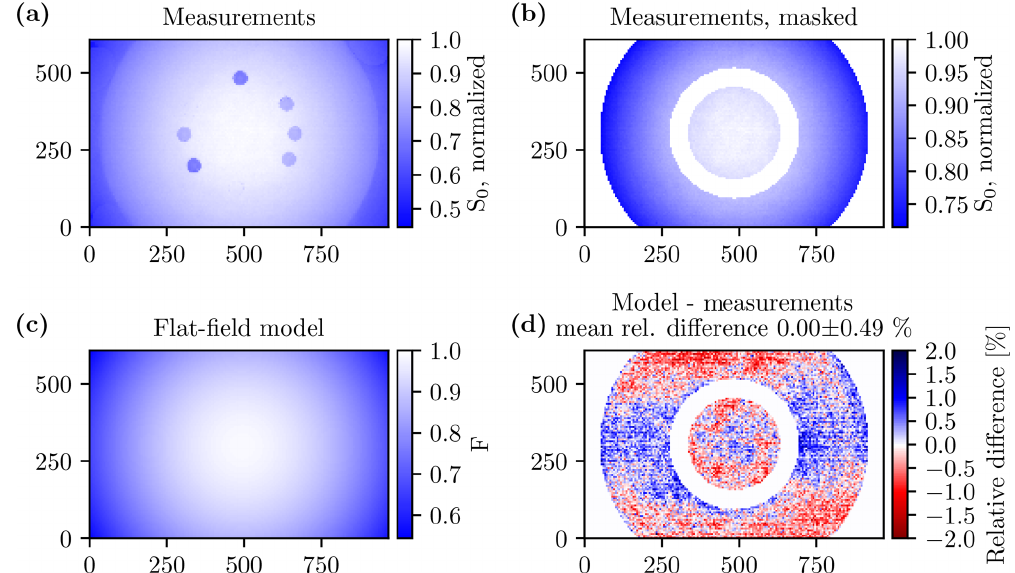
Figure 6. (a) HaloCam RAW dark-signal-corrected measurements S 0 (R channel), which are normalized to 1, of the large integrating sphere (LIS) averaged over six different camera orientations, with 40 images each. (b) S 0 , normalized to 1, as in (a) with a mask applied to the areas where the holes and the edge of the LIS are visible. (c) Flat-field model for the HaloCam RAW R channel fitted against the measurements with a two-dimensional second-order polynomial. (d) Relative difference between flat-field model and masked measurements.